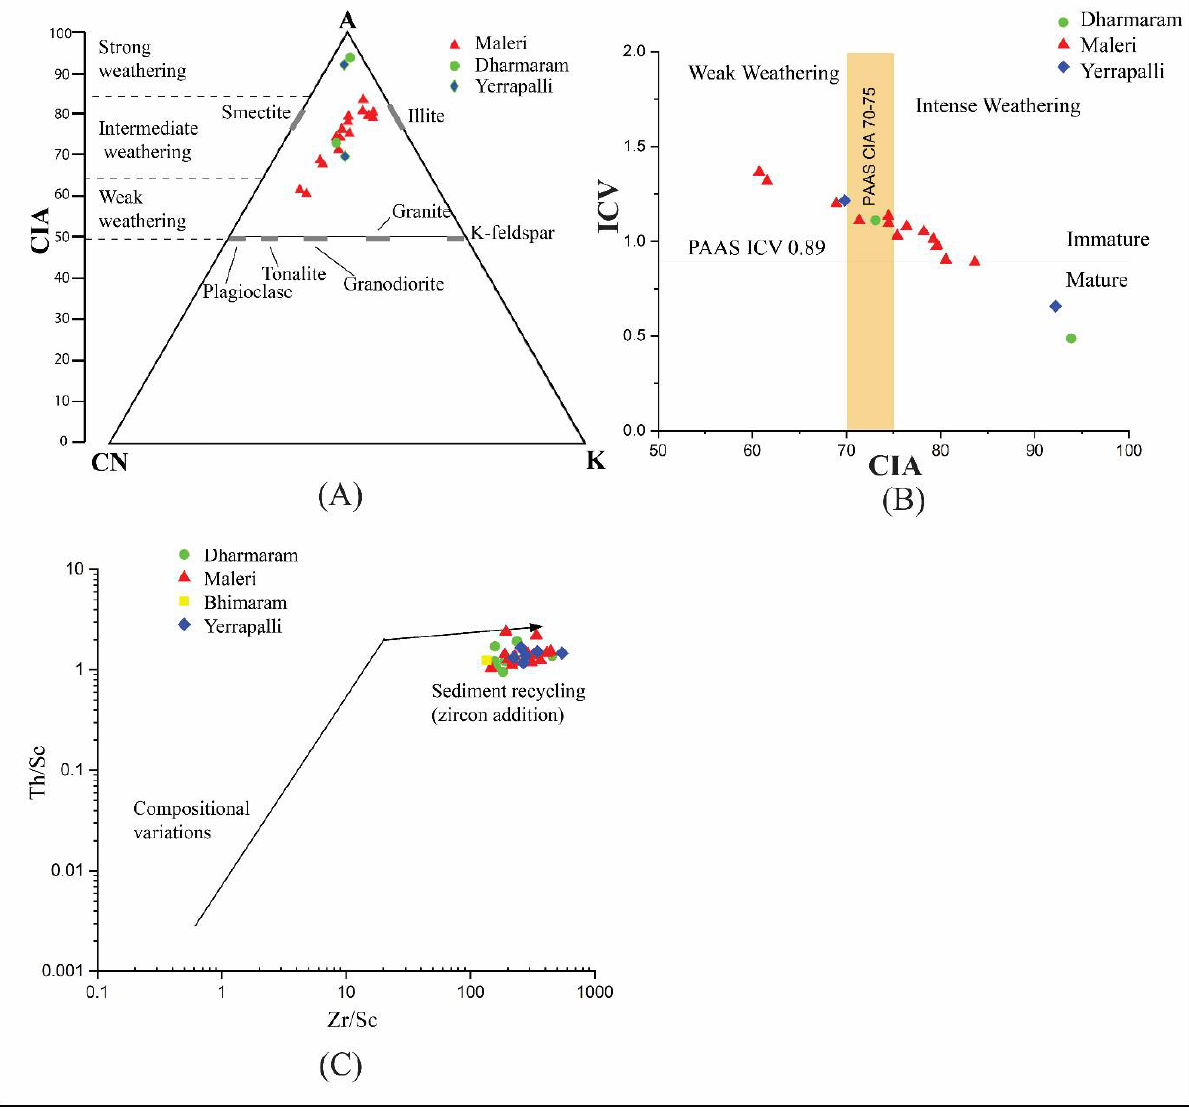
Figure 8. ( A ) Major element composition plot in an A-CN-K [74] diagram indicating the extent of weathering for the mudstone samples of the Yerrapalli, Maleri and Dharmaram formations. ( B ) CIA versus ICV. indicating maturity and intensity of weathering (adapted from [80]) for the mudstone samples of Yerrapalli, Maleri and Dharmaram formations. ( C ) Th/Sc versus Zr/Sc plot of the Gondwana mudstone samples showing enrichment of zircon (high Zr/Sc ratio), indicating derivation of sediment recycling [75].